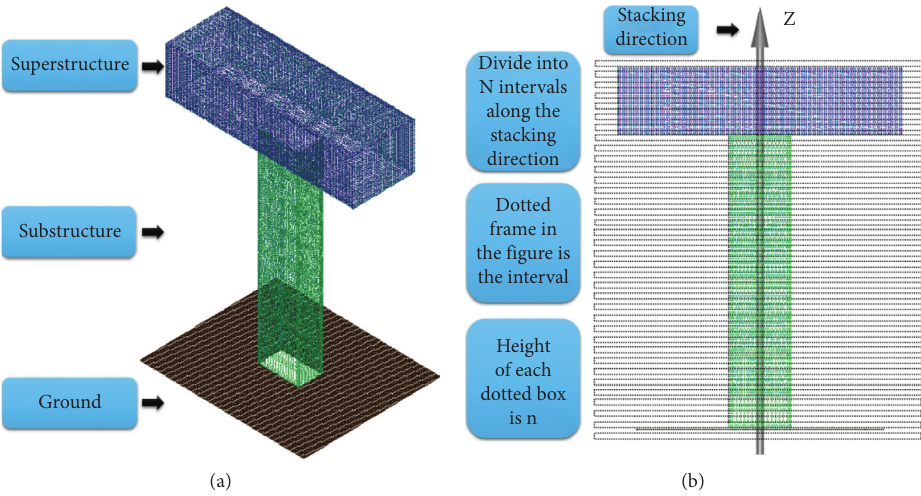
Figure 2: First set of theoretical point clouds: (a) flat surface point cloud; (b) partition along the stacking direction.